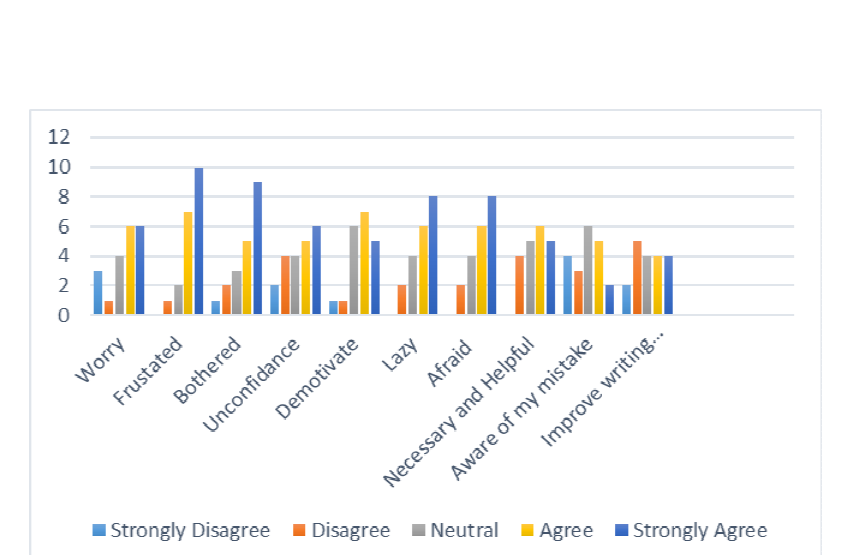
Figure 5. The low-proficiency students’ emotional response to the use of teachers’ written corrective feedback